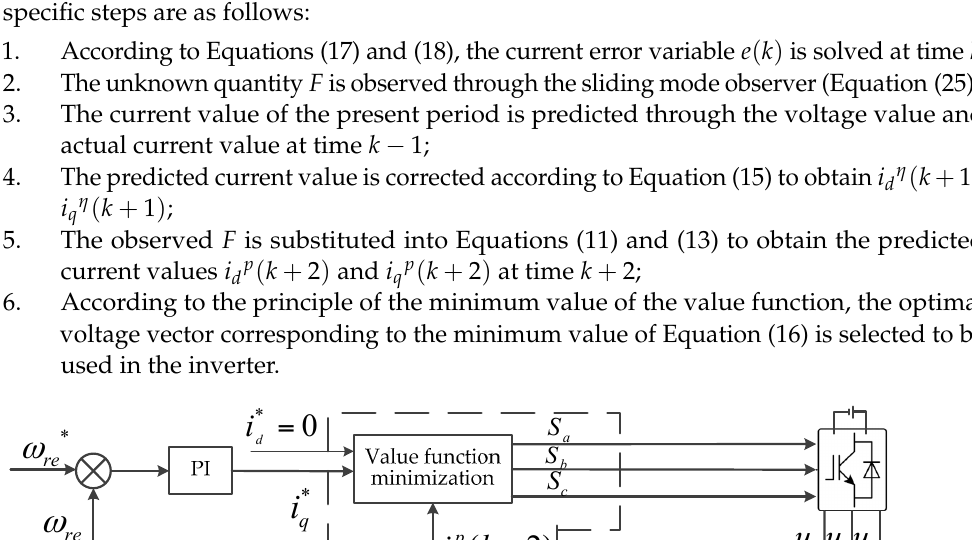
Figure 4. Block diagram of FCS-MPFCC.